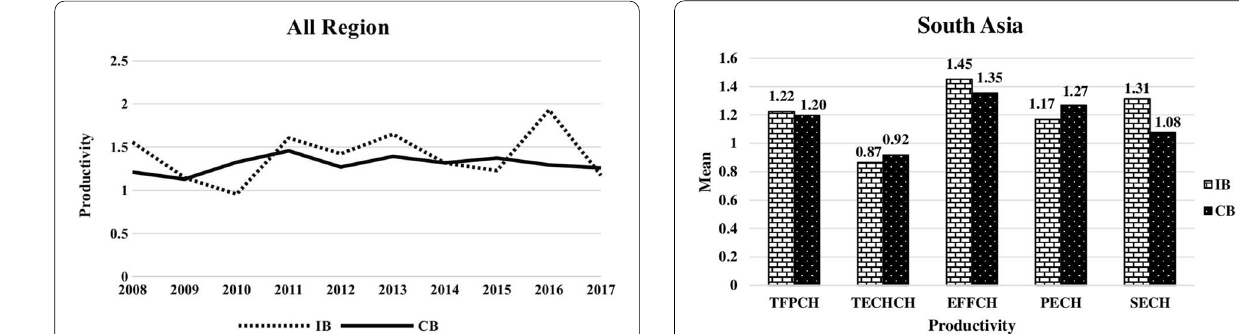
Fig. 5 Levels of productivity by years in all regions